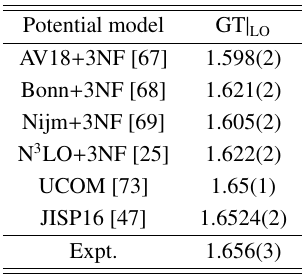
Table 3. The dependence of the triton β -decay leading order GT matrix-element on the potential